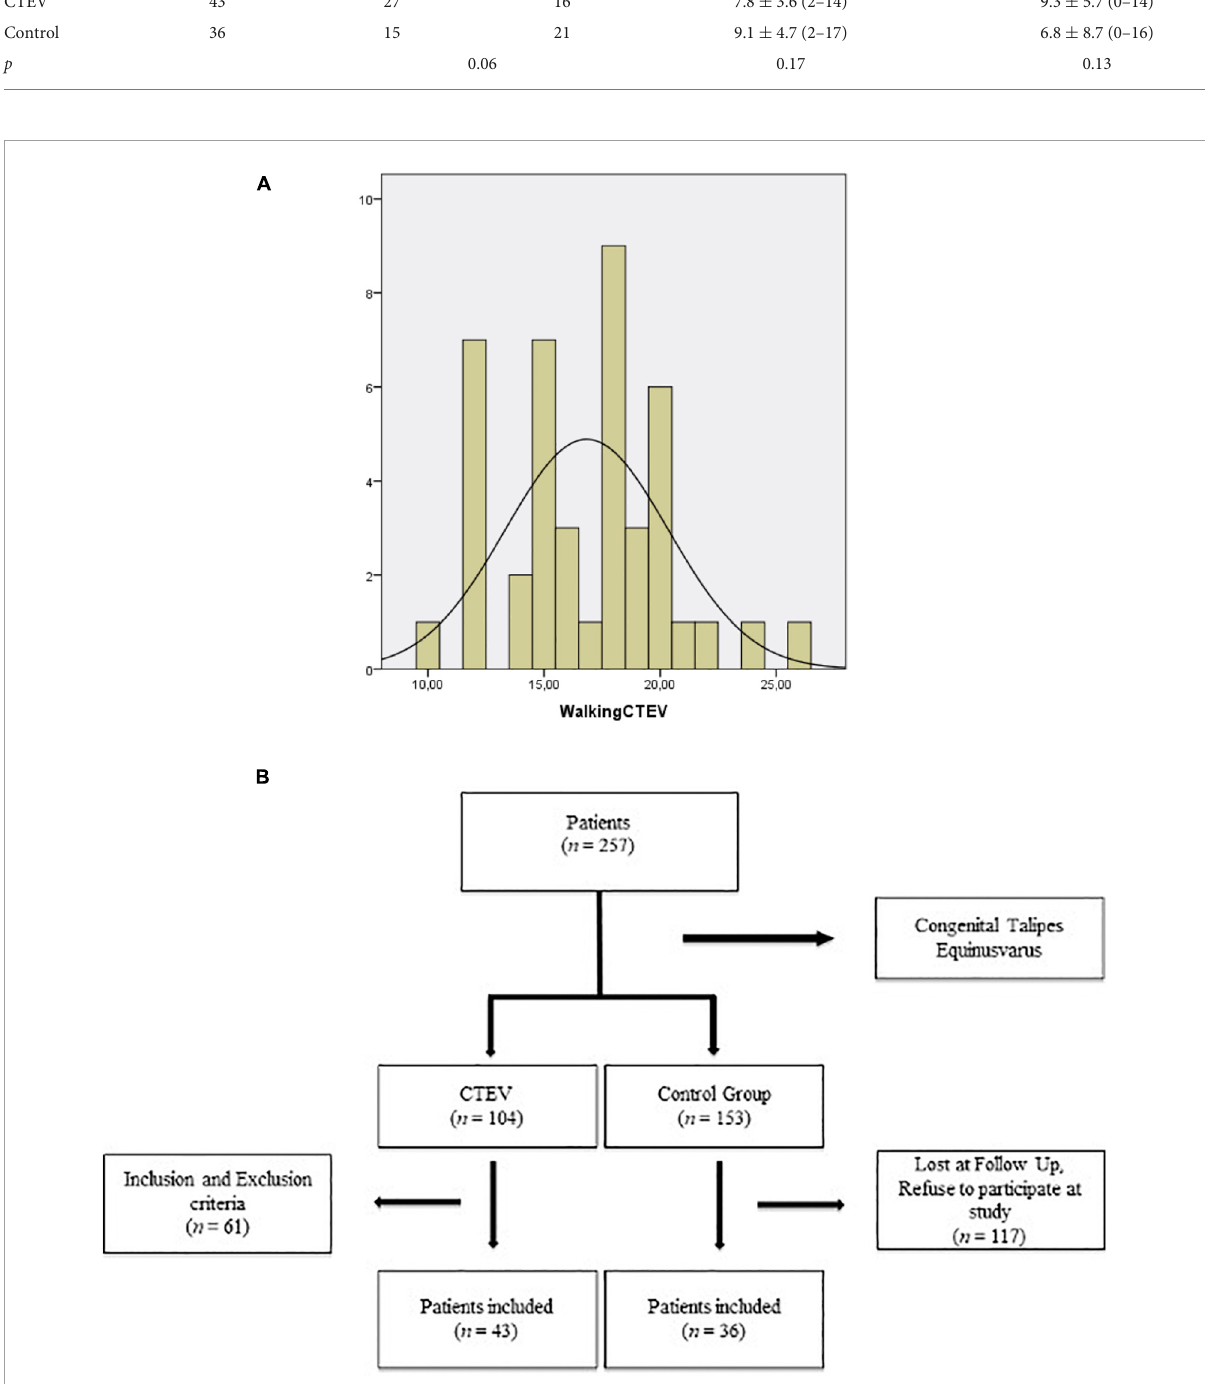
FIGURE3 (A) Distribution of patients with CTEV achieving IG. (B) Distribution of unaffected patients achieving